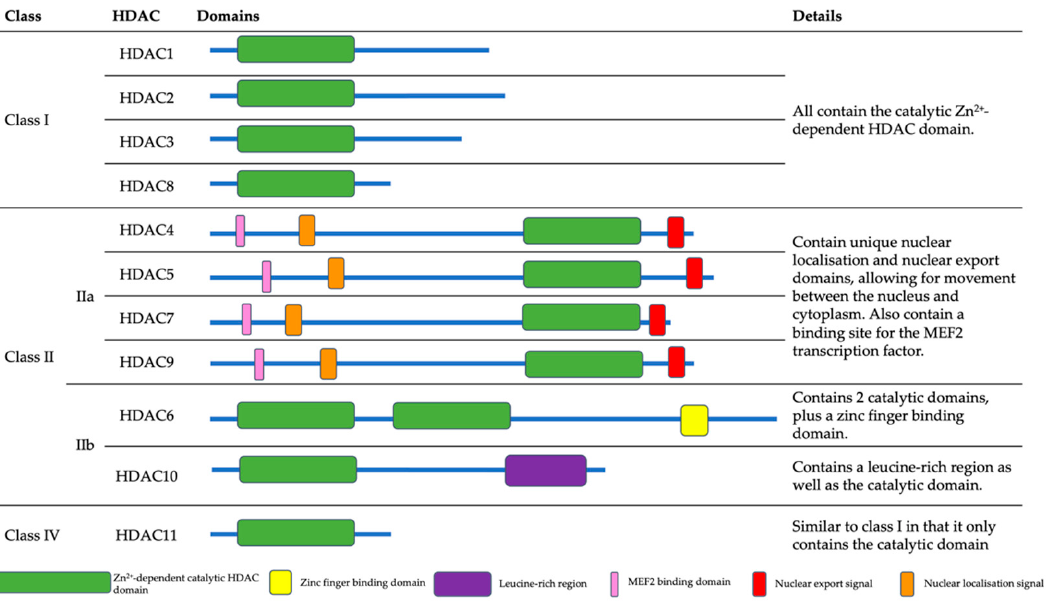
Figure 1. The HDAC structures and domains. Class I, II and IV HDACs all contain a zinc-dependent HDAC domain. The class IIa HDACs also contain MEF2 binding domains, as well as nuclear localisation and export signals. HDAC6 alone has a zinc finger binding domain, whereas HDAC10 has a leucine-rich region.